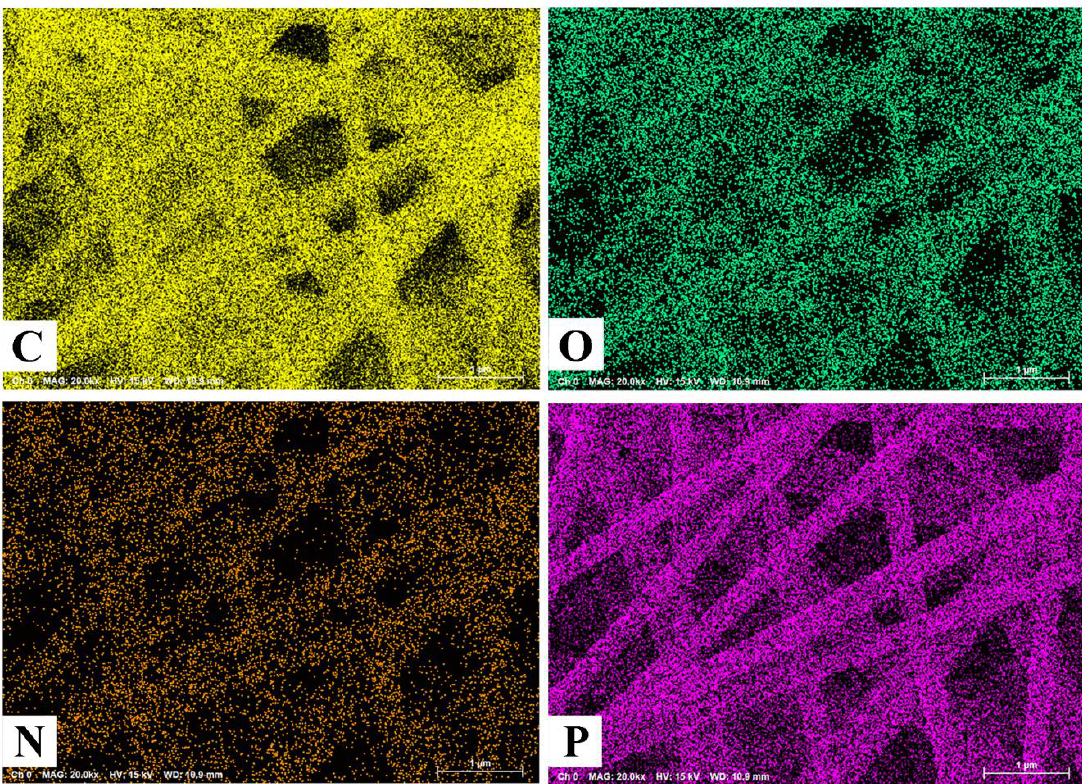
Figure 1. SEM images of ( a ) ACF-0; ( b ) ACF-3.9% PDPP; ( c ) ACF-6.4% PDPP; ( d ) ACF-10.3% PDPP;